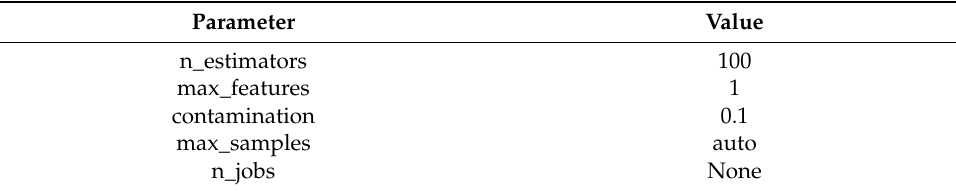
Table 1. Parameter settings for the iForest algorithm.